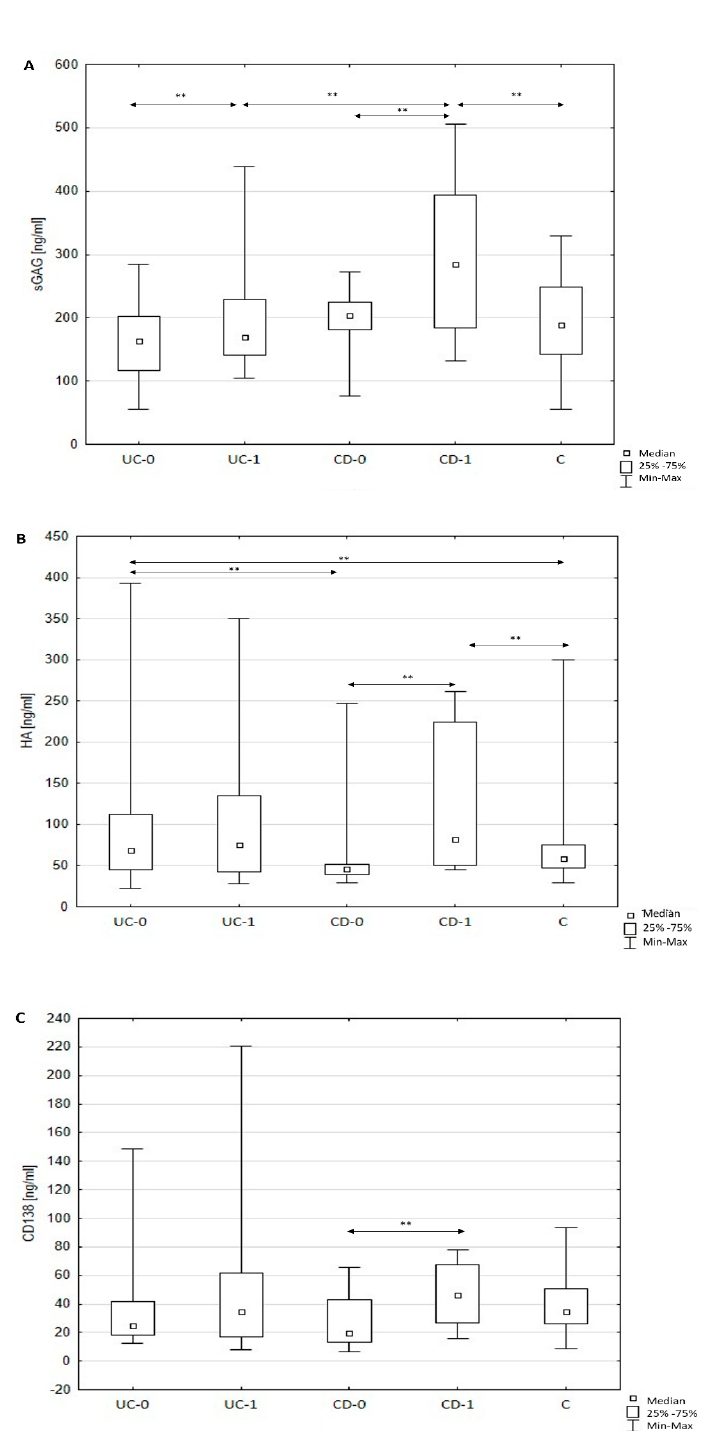
Figure 1. ( A – C ) Circulating total sulfated glycosaminoglycans (GAGs), hyaluronic acid (HA), and soluble syndecan-1 (sCD138) levels in healthy subjects and patients with inflammatory bowel diseases (IBD) before and after 12-month therapy. Note: Results are expressed as median, interquartile (25th–75th percentiles) range, and minimum and maximum of data in the groups. C: healthy subjects (control); UC-0: patients with ulcerative colitis before adalimumab therapy; UC-1: patients with ulcerative colitis after 12-month adalimumab therapy; CD-0: patients with Crohn’s disease before prednisone therapy; CD-1: patients with Crohn’s disease after 12-month prednisone therapy. HA, hyaluronic acid; sGAG, sulfated glycosaminoglycans; sCD138, soluble syndecan-1; ** p < 0.01, statistically